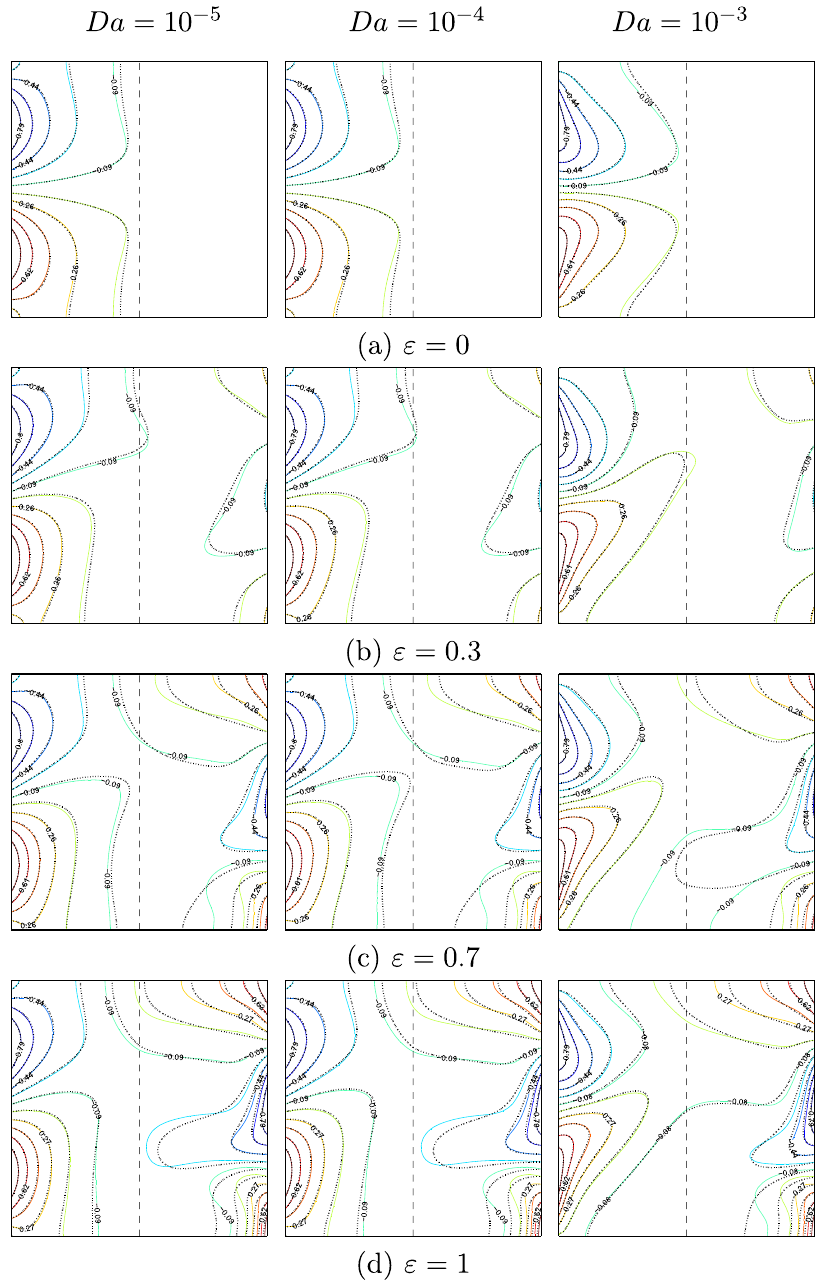
Figure 7. Isotherms evolution by ε and Da for Ra bf = 10 5 , γ = π (dashed